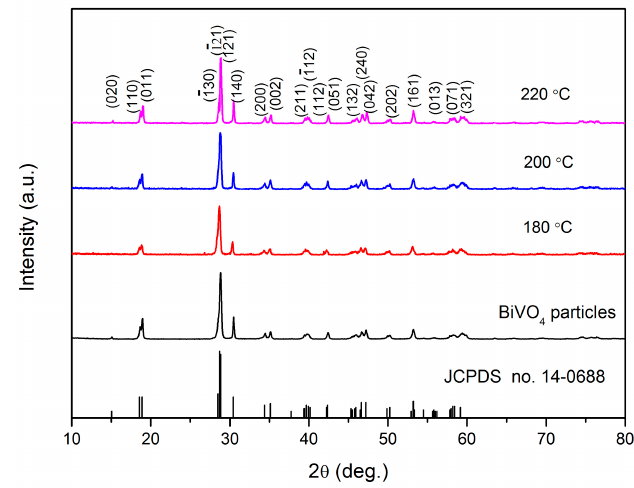
Figure 1. XRD patterns of BiVO 4 particles and BiVO 4 samples prepared at various hydrothermal temperatures.